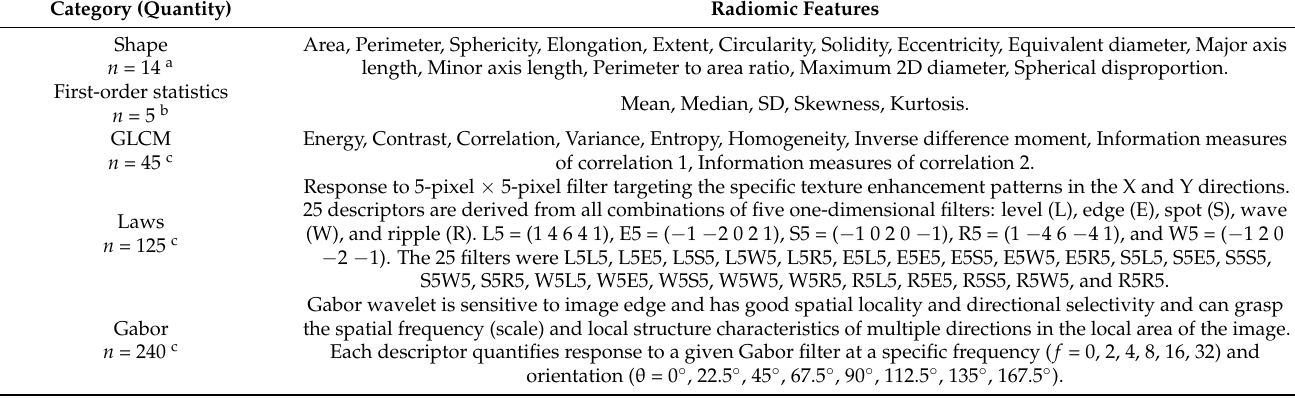
Table 1. List of Radiomic